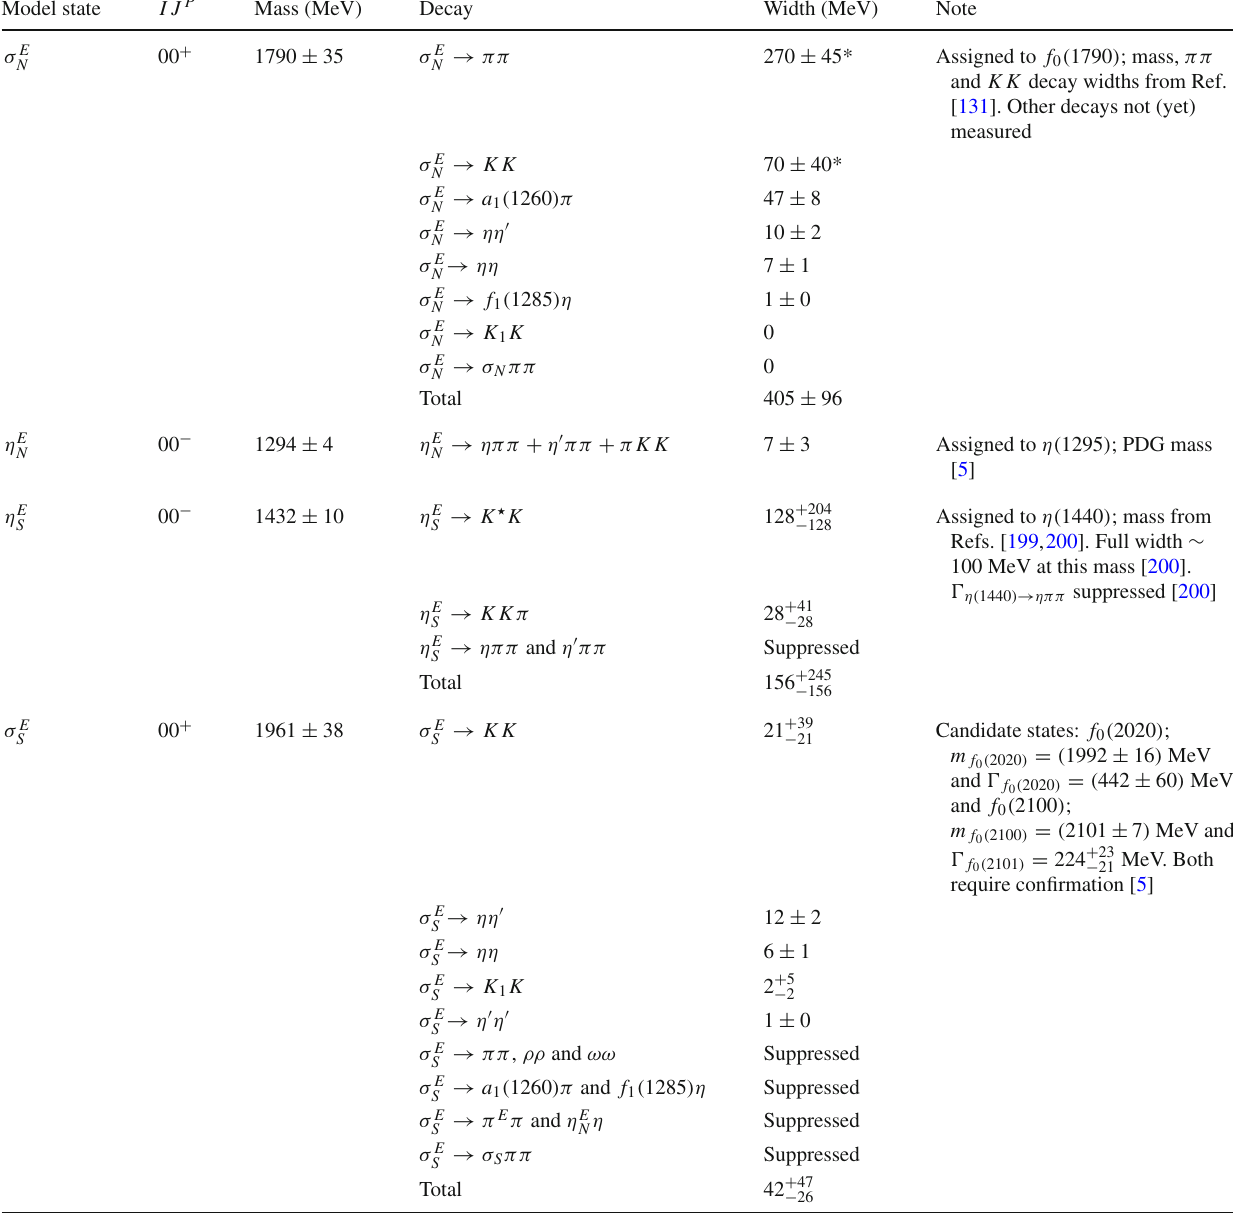
Table 4 Decays and masses of the excited ¯ qq states. Widths marked as “suppressed” depend only on large- N c suppressed parameters that have been set to zero. Widths marked with an asterisk are used as input; the others are predictions Model